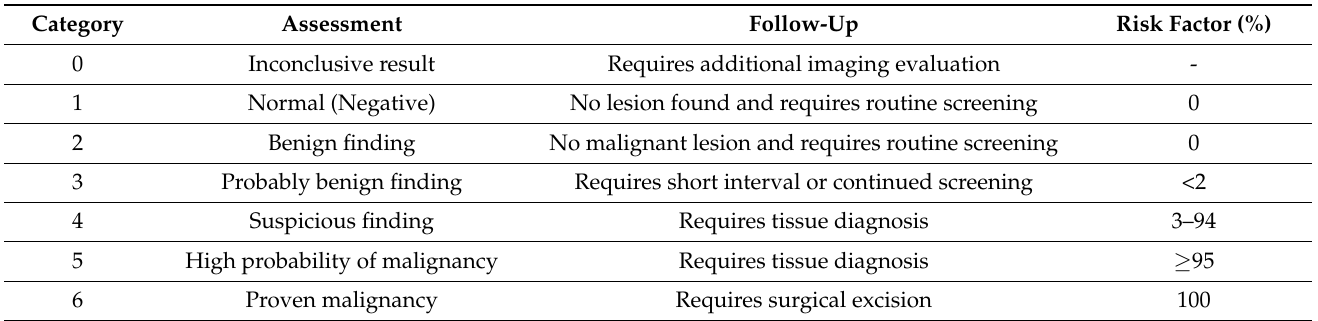
Table 1. Assessment of BI-RADS categories for mammogram classification